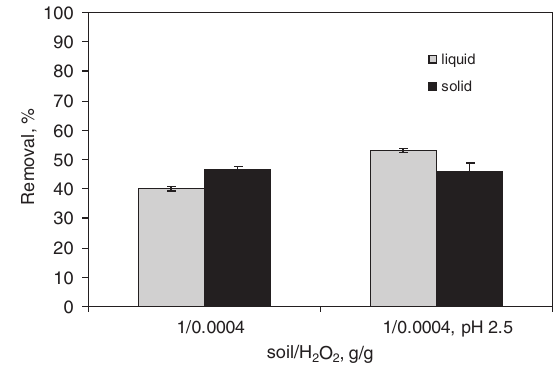
Fig. 4. Total contaminant removal (% of initial content) in soil after 24 h of treatment with liquid hydrogen peroxide and percarbonate at both a natural soil pH and a pH pre- adjusted to 2.5. The error bars represent the standard deviation of the replicates (n (cid:31)